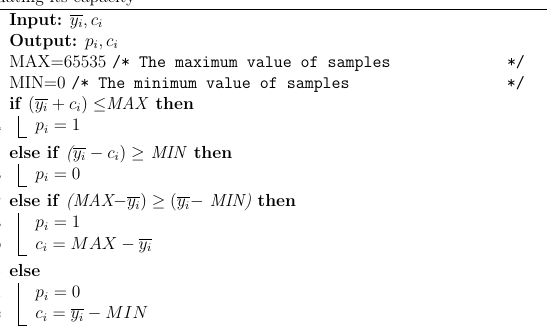
Algorithm 1: Finding the position of the sampling space and up- dating its